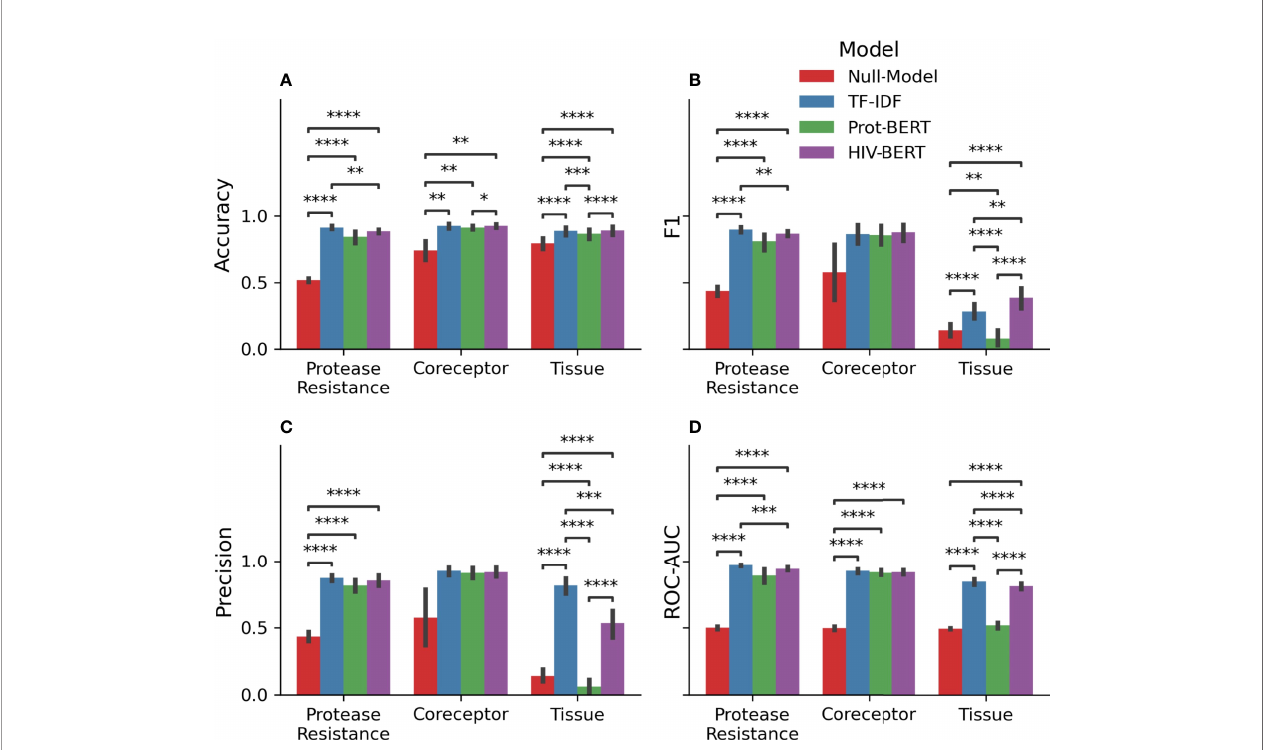
FIGURE 3 | Pretraining improves prediction metrics across all tasks. The accuracy (A) , F1-score (B) , precision (C) , and AUC (D) are shown for each model and each prediction task. The bar indicates the mean value and the error bars represent the 95% con fi dence interval of 5-fold cross validation. The Null model is shown in red, the TF-IDF model is show in blue, the Prot-BERT model in green, and the HIV-BERT model is in purple. The test-comparison bars represent the results of a paired t-test between each group; undrawn comparisons p<0.05, *(0.05<p<=0.01), **(0.01<p<=0.001), ***(0.001<p<=0.0001), ****(p<=0.00001). A Bonferroni correction based on all possible tests in the fi